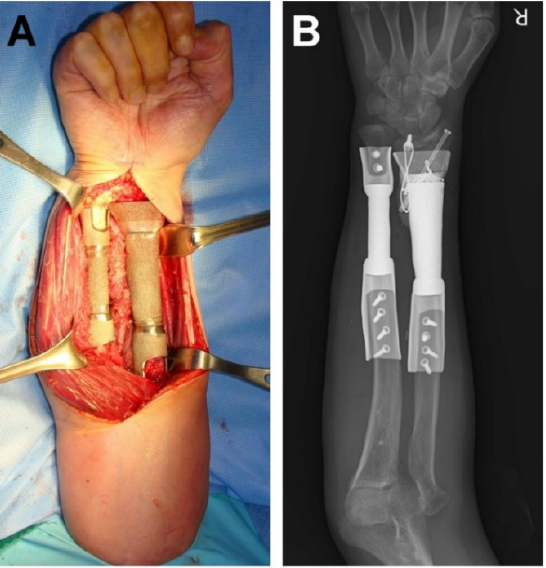
Figure 1. Primary surgery. ( A ) Intraoperative photograph and ( B ) postoperative plain radiograph showing the general configuration of an implant.